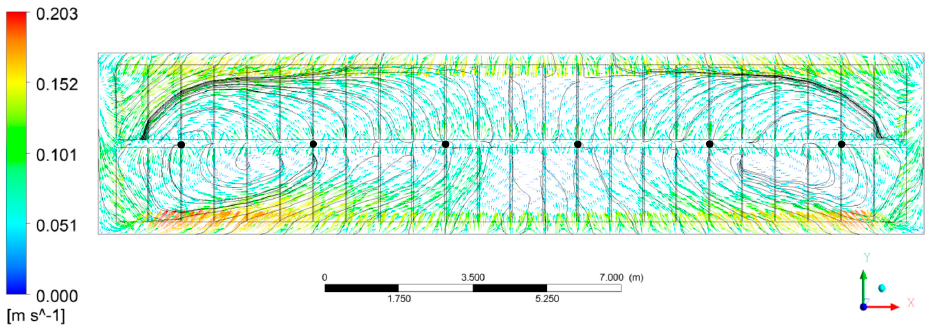
Figure 3. Velocity vectors of the bath flow in the middle horizontal plane of ACD of Case 0.